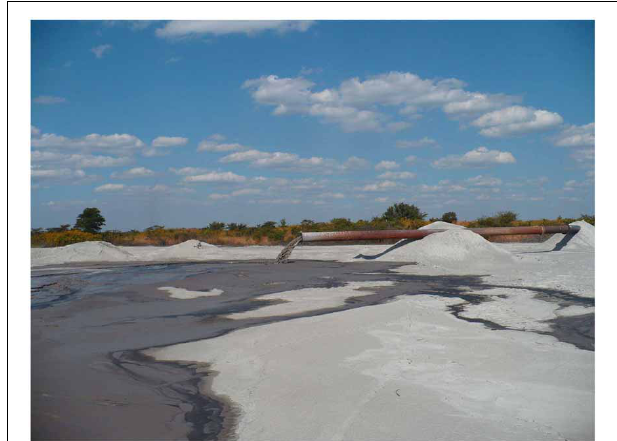
FIGURE 3 | Mindolo: deposition of fresh tailings.